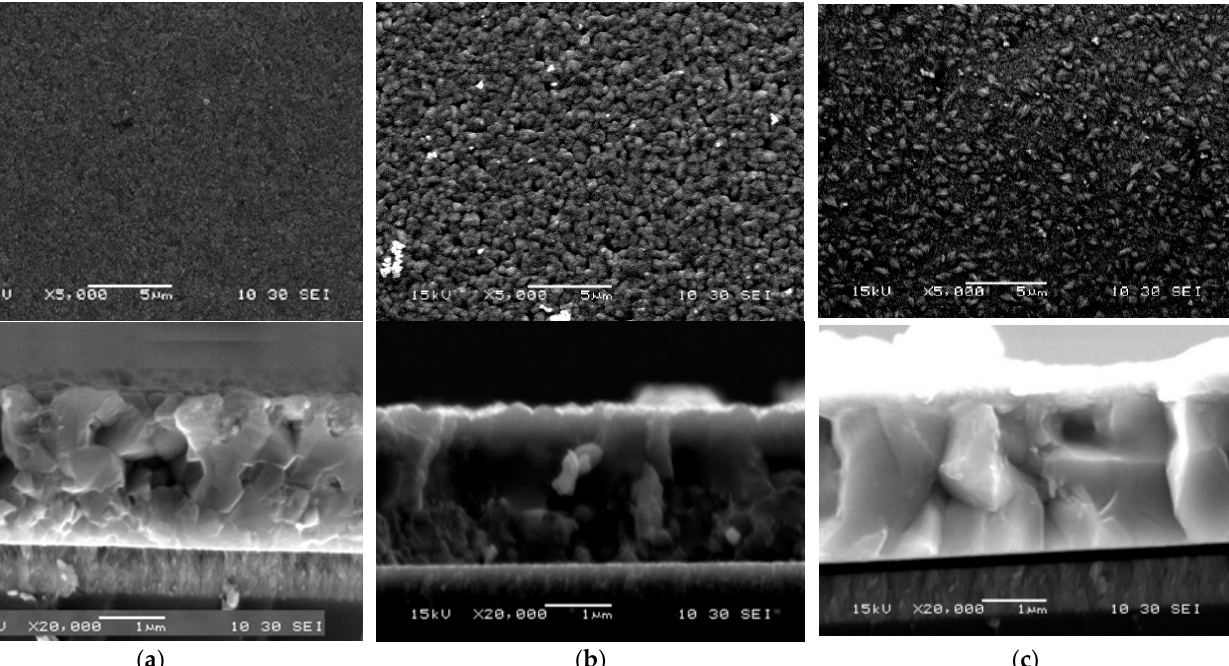
Table 4. XRD and XRF results for reference, third stage LT and third stage HT CIGS samples. Samples